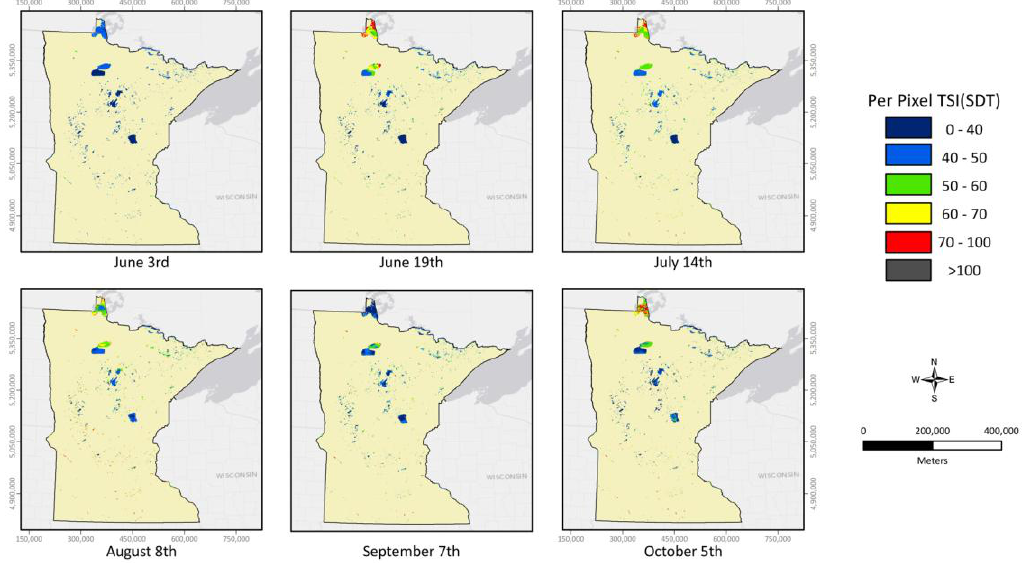
Figure 1. MODIS-predicted TSI values per pixel in the statewide water mask. (SDT) Significant within-lake water clarity variation is clearly visible in larger lakes. Seasonal progression in image dates is shown from left to right by row